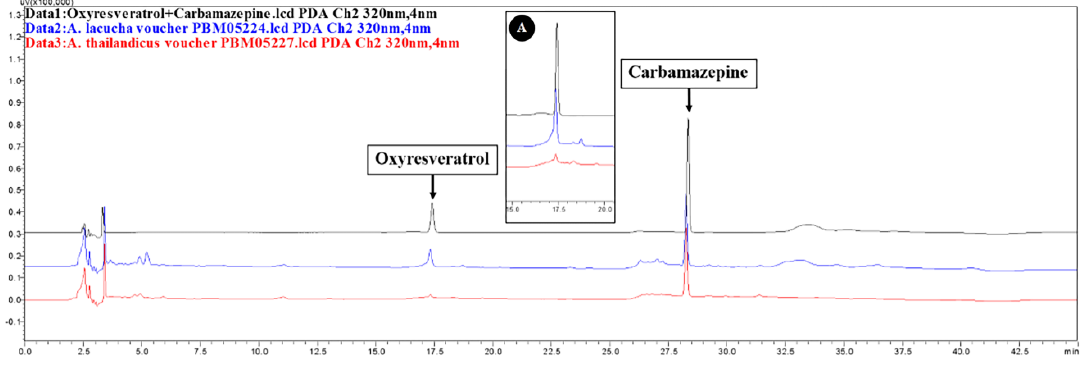
Figure 6. HPLC chromatograms of A. lacucha and A. thailandicus twig extract alignment. Oxyresveratrol standard and carbamazepine (internal standard) were detected at the retention time of 17.3 (Figure 6A) and 28.3 min, respectively. The HPLC chromatograms of oxyresveratrol (black line), A. lacucha voucher PBM05224 (blue line) and A. thailandicus voucher PBM05227 (red line) were selected as representative of each species and aligned in order to comparison.